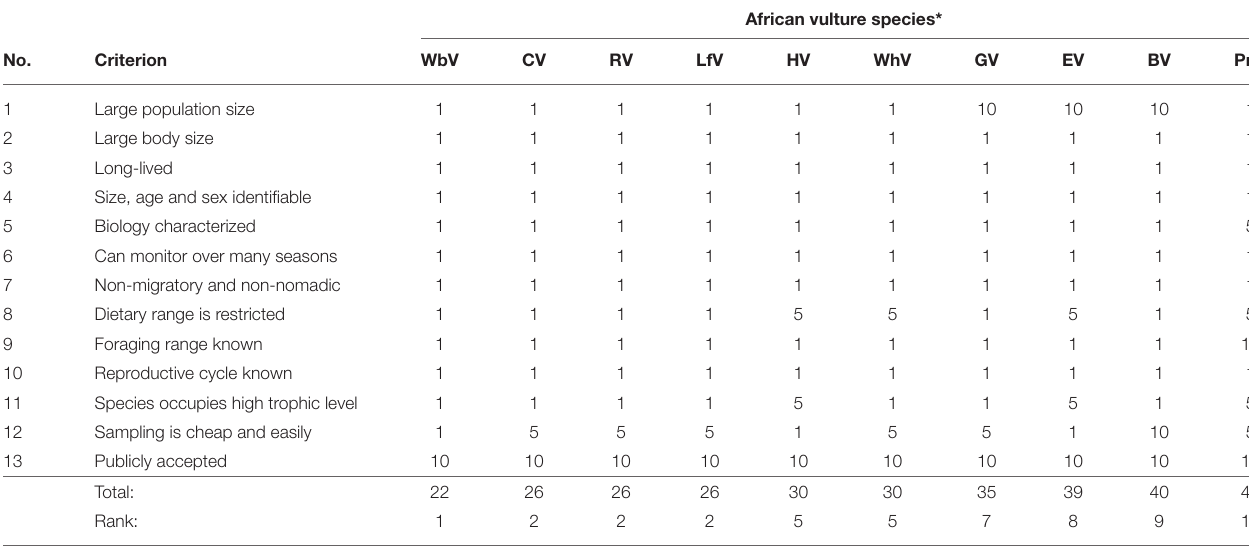
African vulture species*